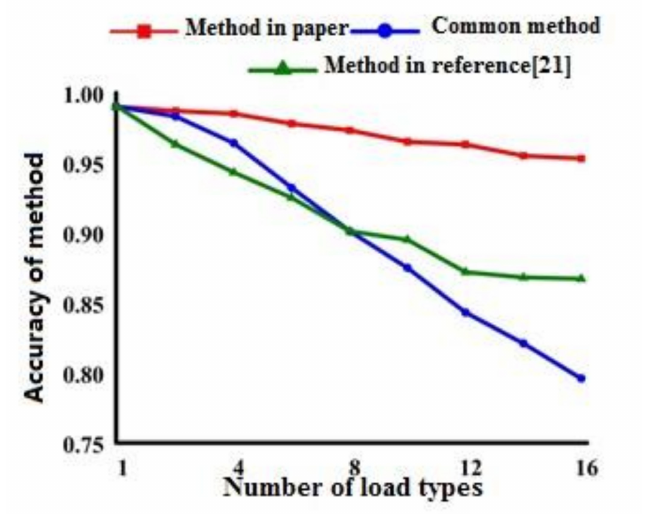
Figure 10. Comparison between the two